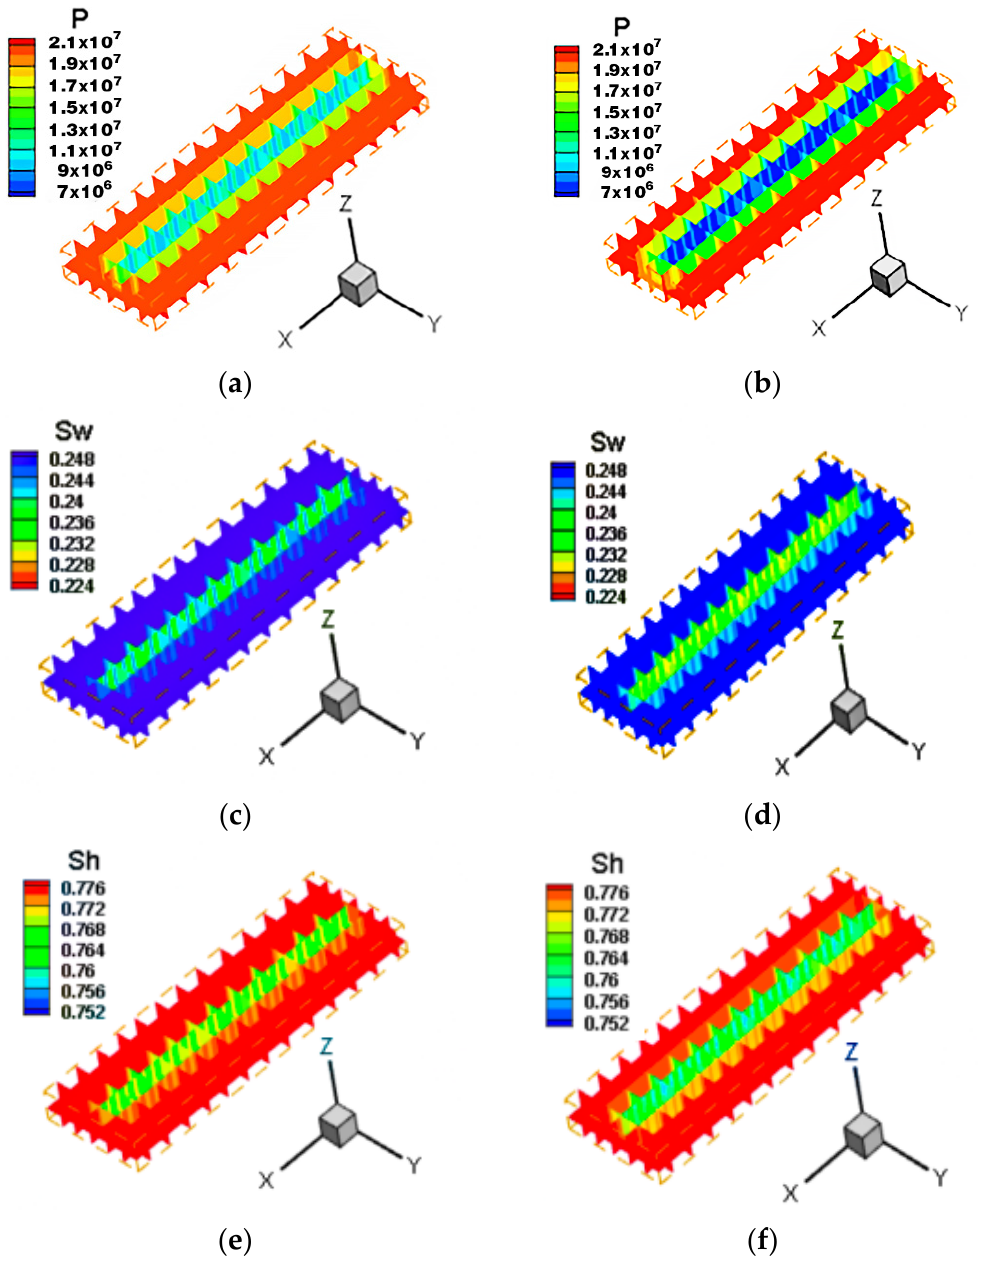
Figure 3. Pressure, water saturation, and gas saturation field diagrams of Barnett horizontal well in different production periods: ( a ) Pressure distribution of Barnett horizontal well over 800 days of production; ( b ) Pressure distribution of Barnett horizontal well over 1600 days of production; ( c ) water saturation distribution of Barnett horizontal well over 800 days of production; ( d ) water saturation distribution of Barnett horizontal well over 1600 days of production; ( e ) gas saturation distribution of Barnett horizontal well over 800 days of production; ( f ) gas saturation distribution of Barnett horizontal well over 1600 days of